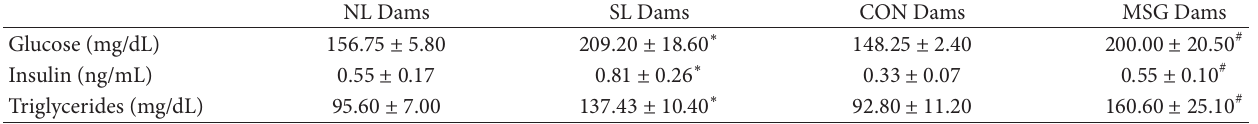
Table 1: Maternal metabolic parameters in blood from lactating dams at 21 days of lactation.